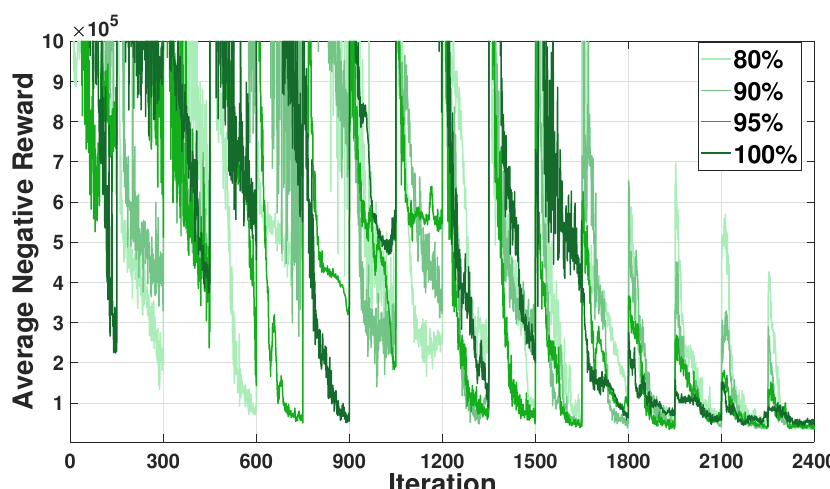
Figure 5. Average negative reward convergence for the heating, ventilation, and air conditioning (HVAC) agents with varying amounts of selective parameter